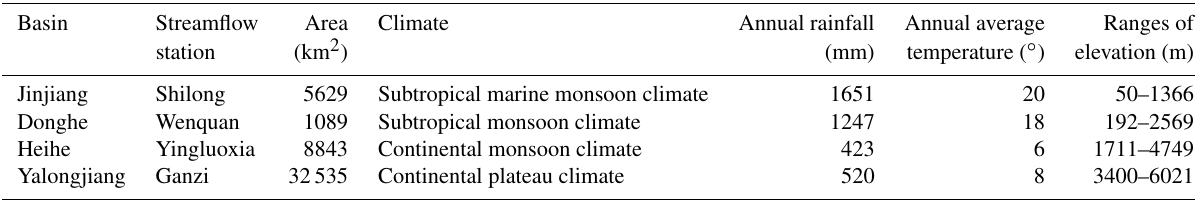
Table 1. Main characteristics of the four basins being studied. Basin Streamflow Area Climate